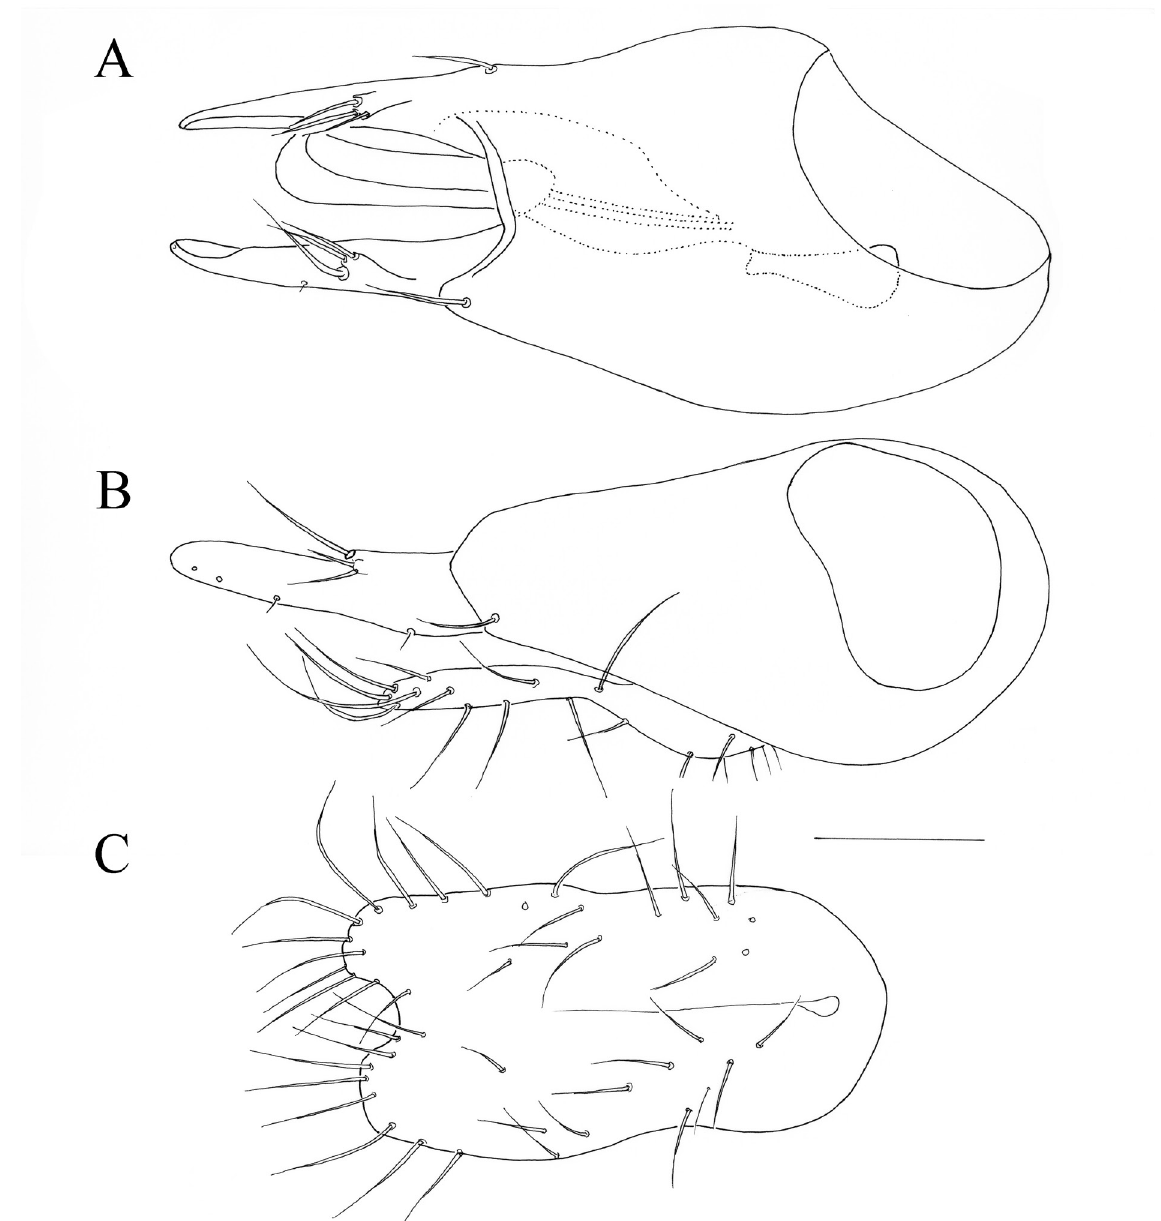
Fig. 10. Thinophilus subapicalis Samoh & Grootaert sp. nov. Male terminalia (Abdulloh Samoh leg., PSUNHM (PSUZCDIP0015)). A . Ventral view of hypopygium. B . Lateral view. C . Dorsal view of cerci. Scale = 0.1